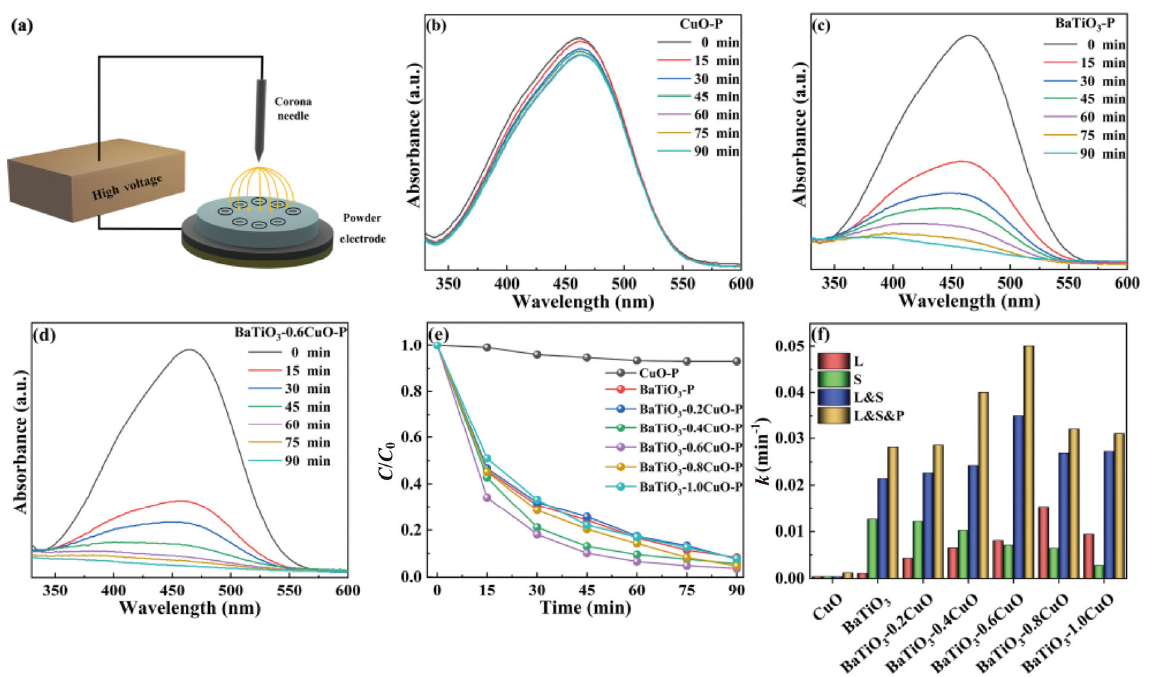
Fig. 7 (a) Illustration of the corona-poling system. UV–Vis absorption spectra of MO solutions undergoing both different UV irradiation and vibration time for (b) poled CuO NPs, (c) poled BaTiO 3 NWs, and (d) poled BaTiO 3 –0.6CuO. (e) Comparison of piezo-photocatalytic activity of MO degradation with poled hybrid catalysts. (f) Comparison of degradation rate constant k for degradation of MO under various catalytic conditions (S refers to ultrasonic vibration, L refers to UV light irradiation, L & S refers to both ultrasonic and UV light, and P refers to the poled